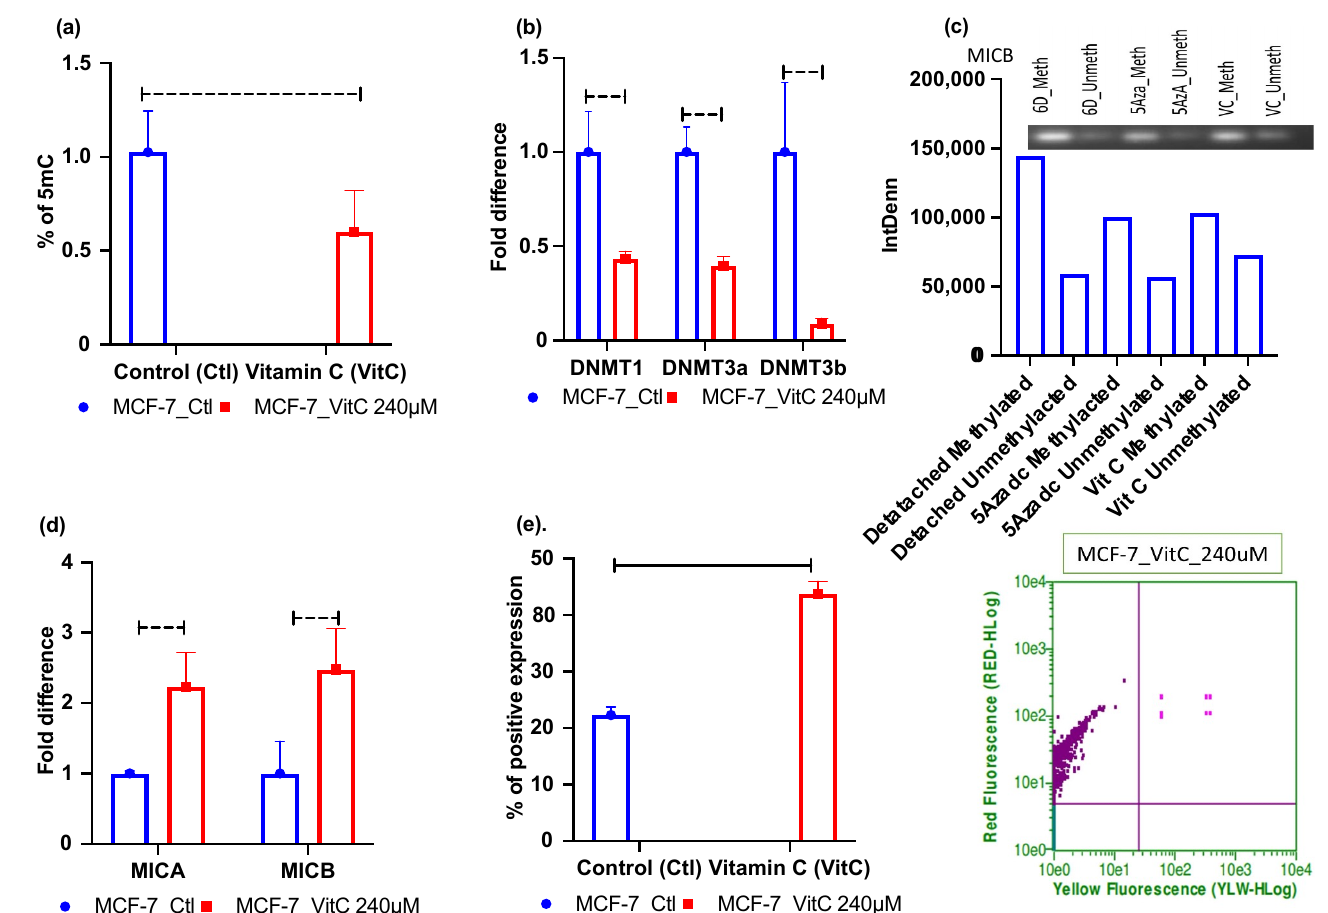
Figure 5. Vitamin C treatment-mediated reduction of global DNA methylation, DNA methyltrans- ferase, and induction of MICA/B expression in ECM-detached MCF-7 cell lines. ( a ) Vitamin C treatment reduced 5mC levels. ( b ) Vitamin C treatment repressed DNMTs mRNA expression. ( c ) MCF-7 cell line showing 5-aza-dc and vitamin C reducing methylation signal in gel electrophoresis com- pared to untreated 6 Days ECM-detached condition. ( d ) Vitamin C treatment increased the fold